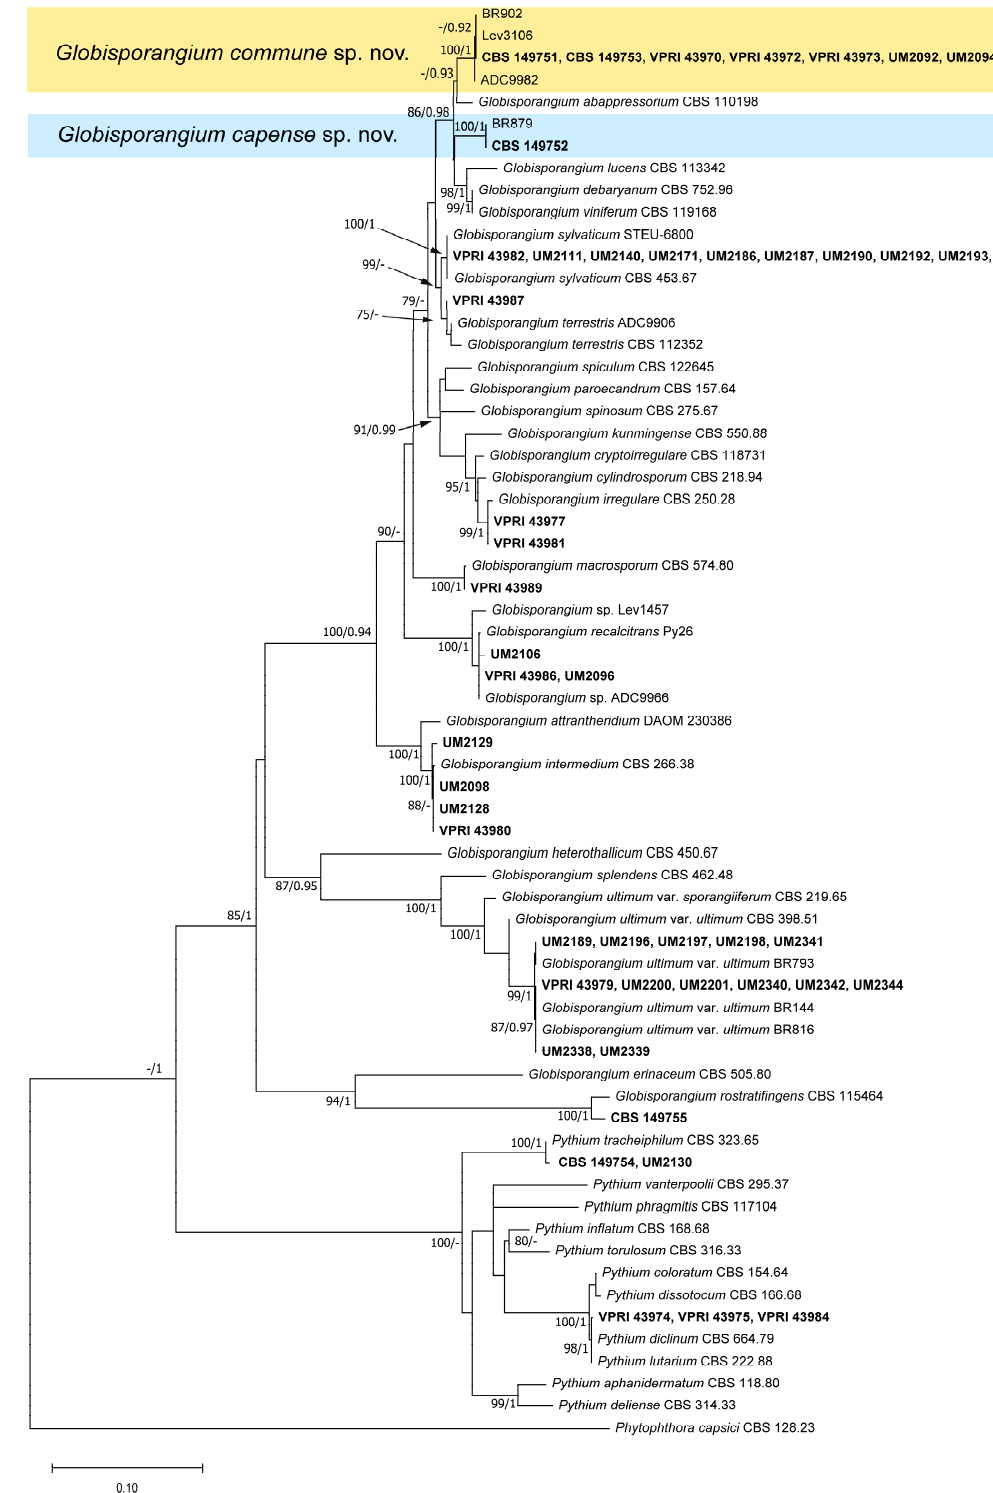
Figure 2. Maximum Likelihood (ML) phylogeny showing relationships among Pythium -like species based on concatenated ITS and Cox1 sequences. Isolates obtained and sequenced in this study are shown in bold. The ML bootstrap support values greater than 75% and Bayesian posterior probability values greater than 0.90 are indicated at internodes. The scale bar shows the number of nucleotide changes per site. The analysis involved 65 nucleotide sequences. The tree was rooted with Phytophthora capsici CBS 128.23 [26]. Two new species are highlighted in color.